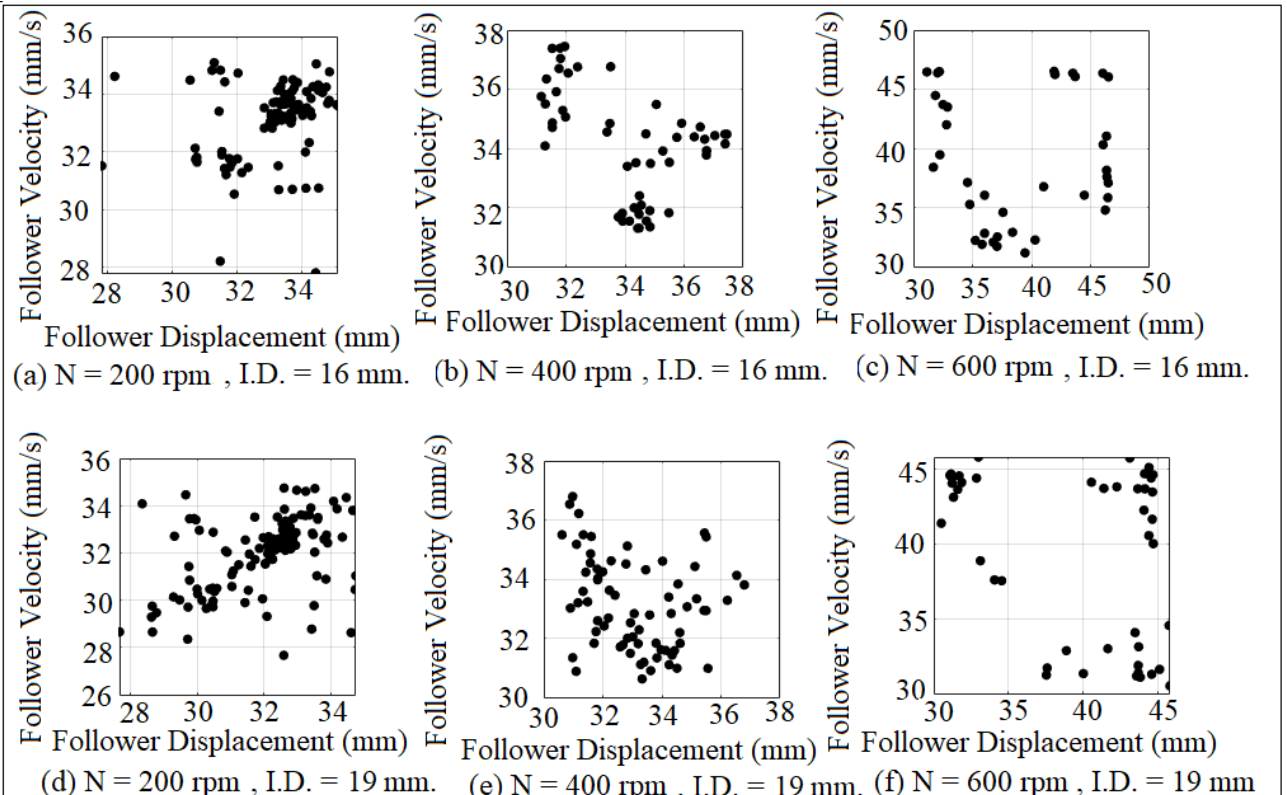
Figure 12. Poincaré maps of chaotic attractor when the follower offsets to the left (O = 20 mm). Figure 12. Poincar é maps of chaotic attractor when the follower offsets to the left (O = 20